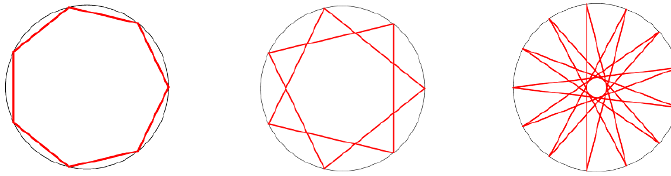
Figure 2. Regular schemes according to Remark